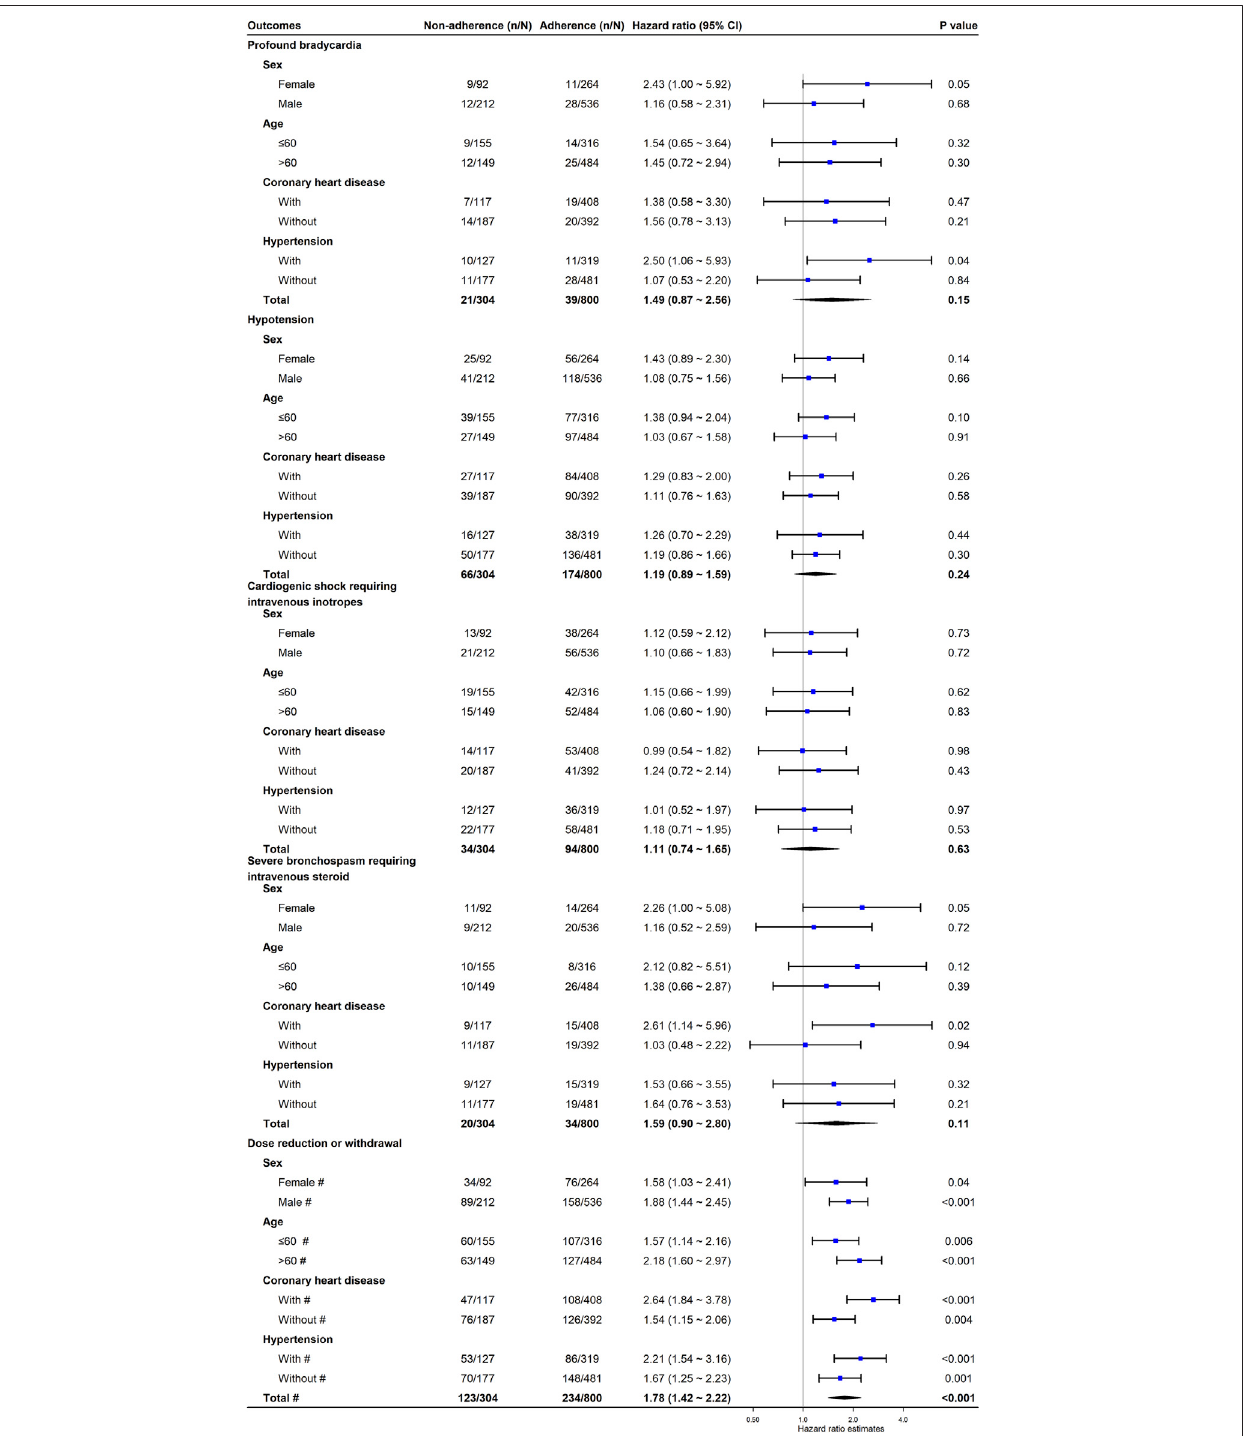
Frontiers in Pharmacology |